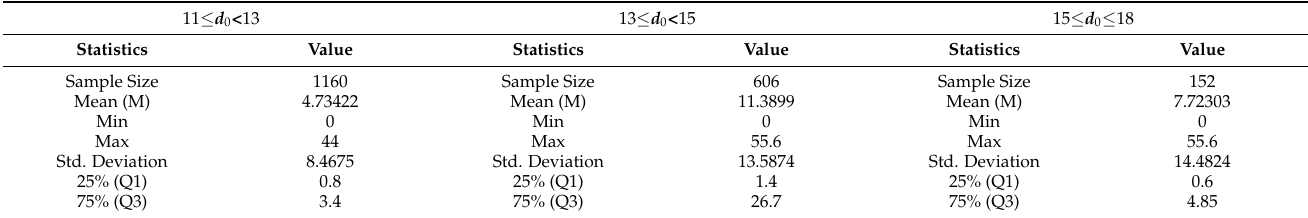
Table 4. The descriptive statistics of the LG empirical